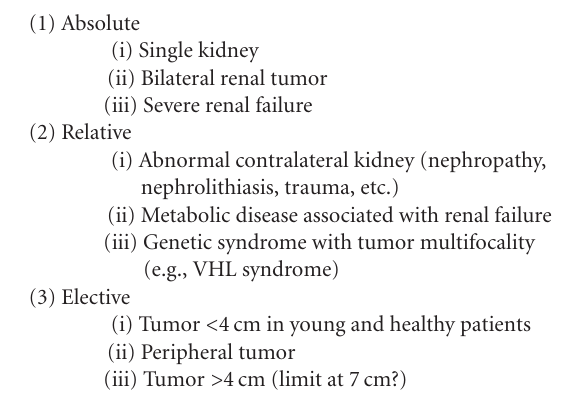
Algorithm 1: Indications for partial nephrectomy.